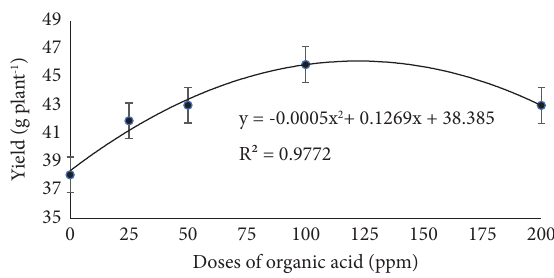
Figure 6: Polynomial regression equation of OAs concentration application on maize